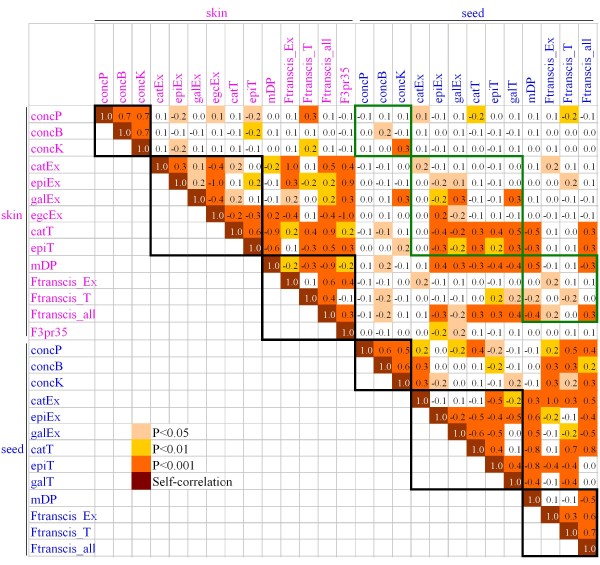
PA variable correlation based on genotypic BLUP of S × G population. The Pearson pairwise correlation coefficient (ρ) is shown and colour codes give the significance of correlation tests. Skin variables are indicated in pink and seed variables are indicated in blue. The bold black lines delimit the pairwise correlation inside a tissue for a given variable category, i.e. total content, subunit percentage and composite variables. The bold green lines delimit the pairwise correlation between tissues for a given variable category.